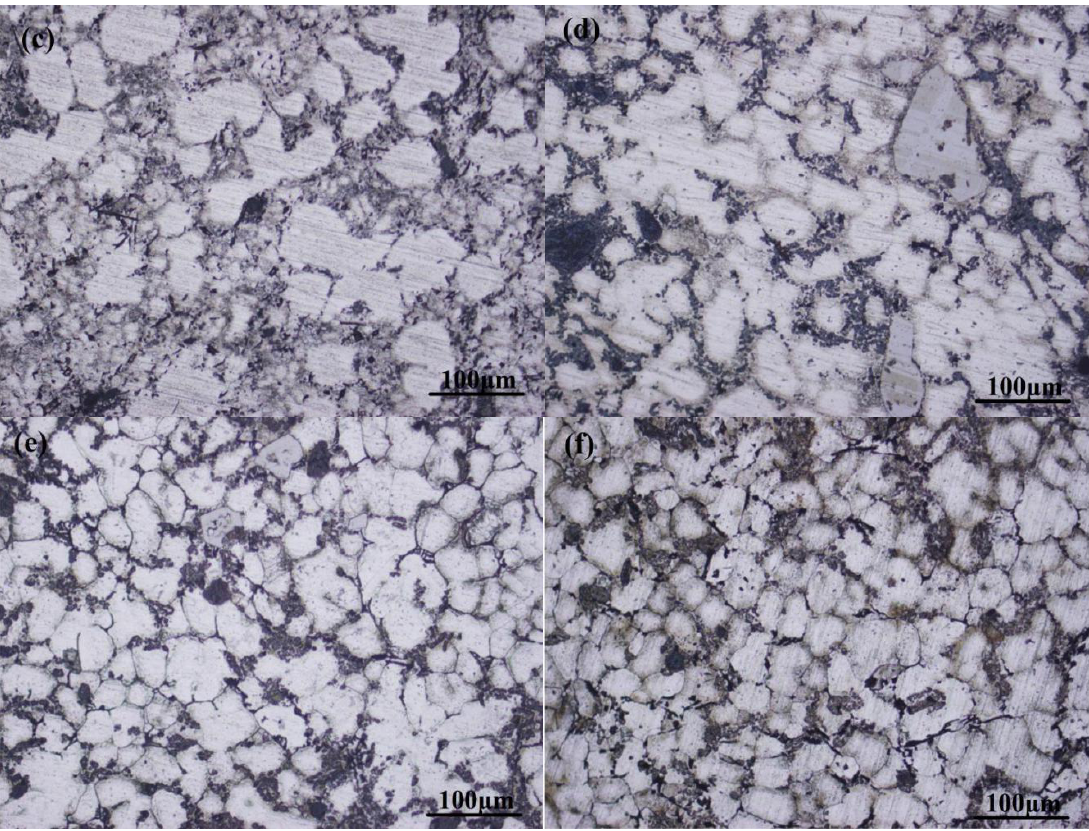
Figure 10. Influence of different stirring time on OM microstructure in location B of the rheoformed 2024 aluminum matrix composite component reinforced by 5 vol % Al 2 O 3 nanoparticles at 620 °C ( a ) 5 min; ( b ) 10 min; ( c ) 15 min; ( d ) 20 min; ( e ) 25 min; ( f ) 30 min.